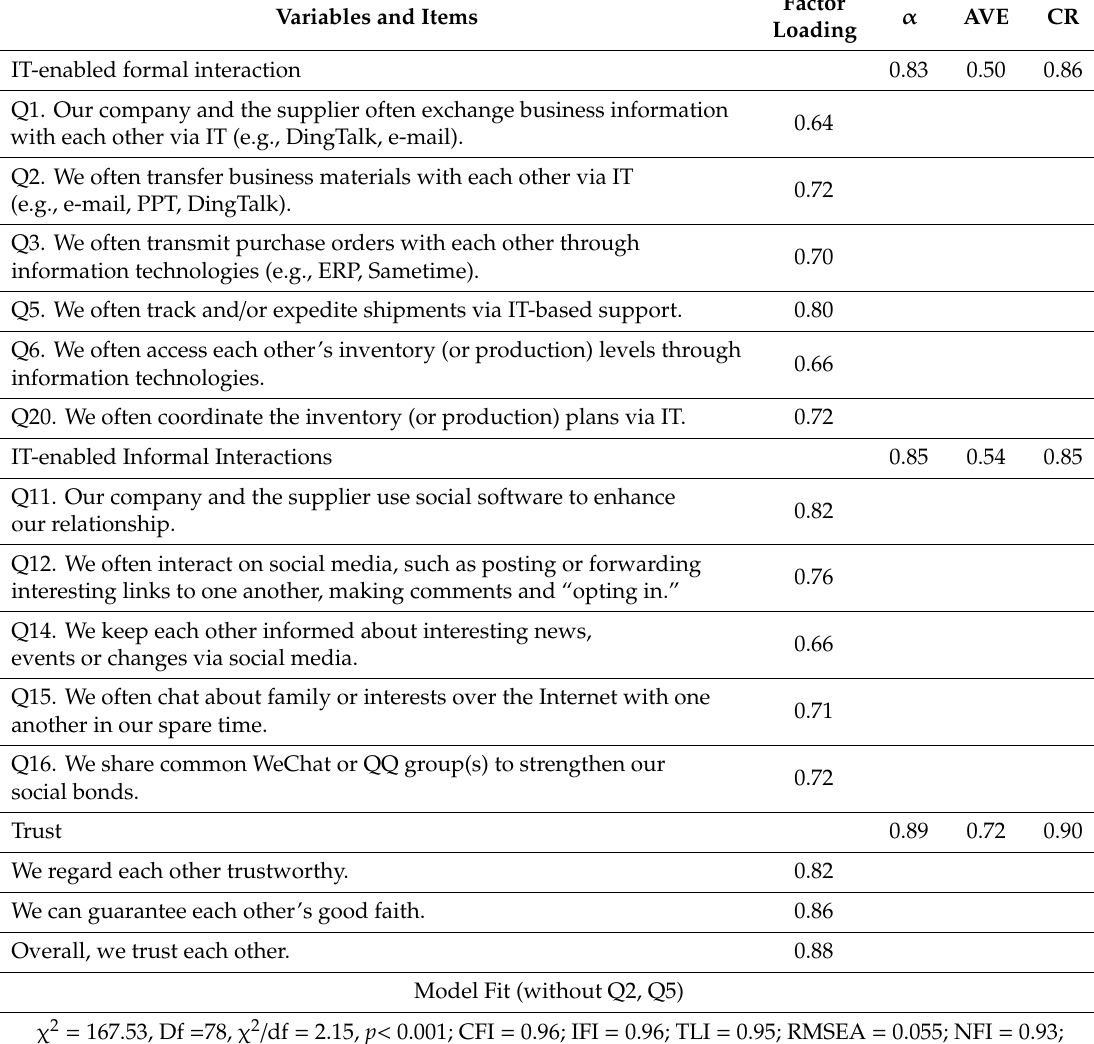
Table 6. Model fit of the prediction